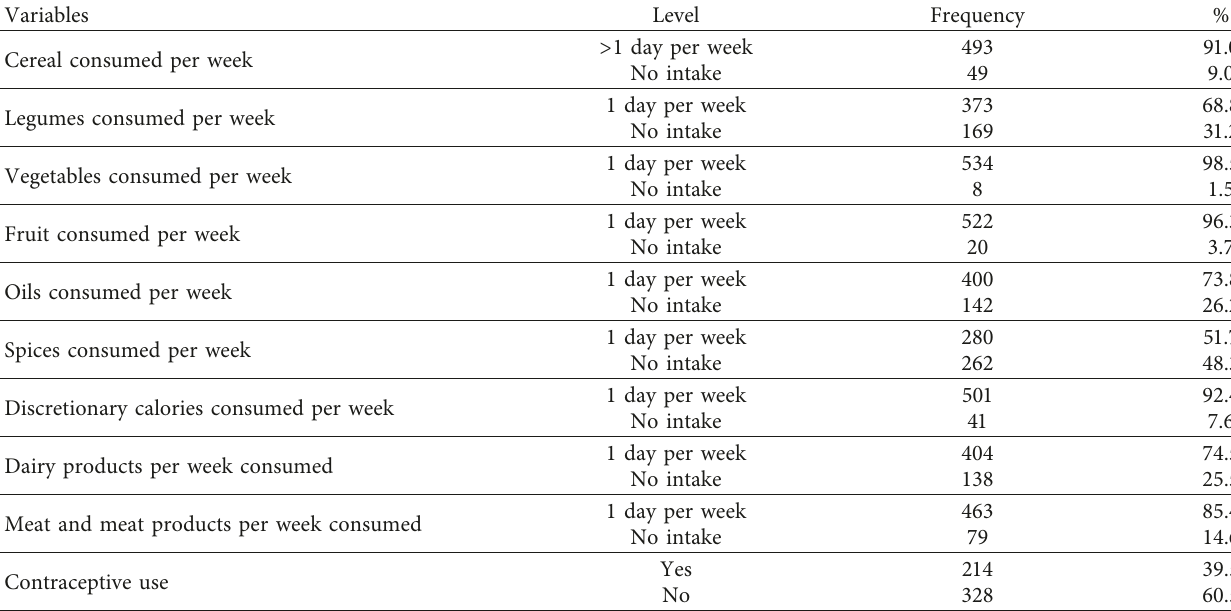
Table 2: Dietary consumption among women of reproductive age in Dire Dawa, 2021 ( n � 542).